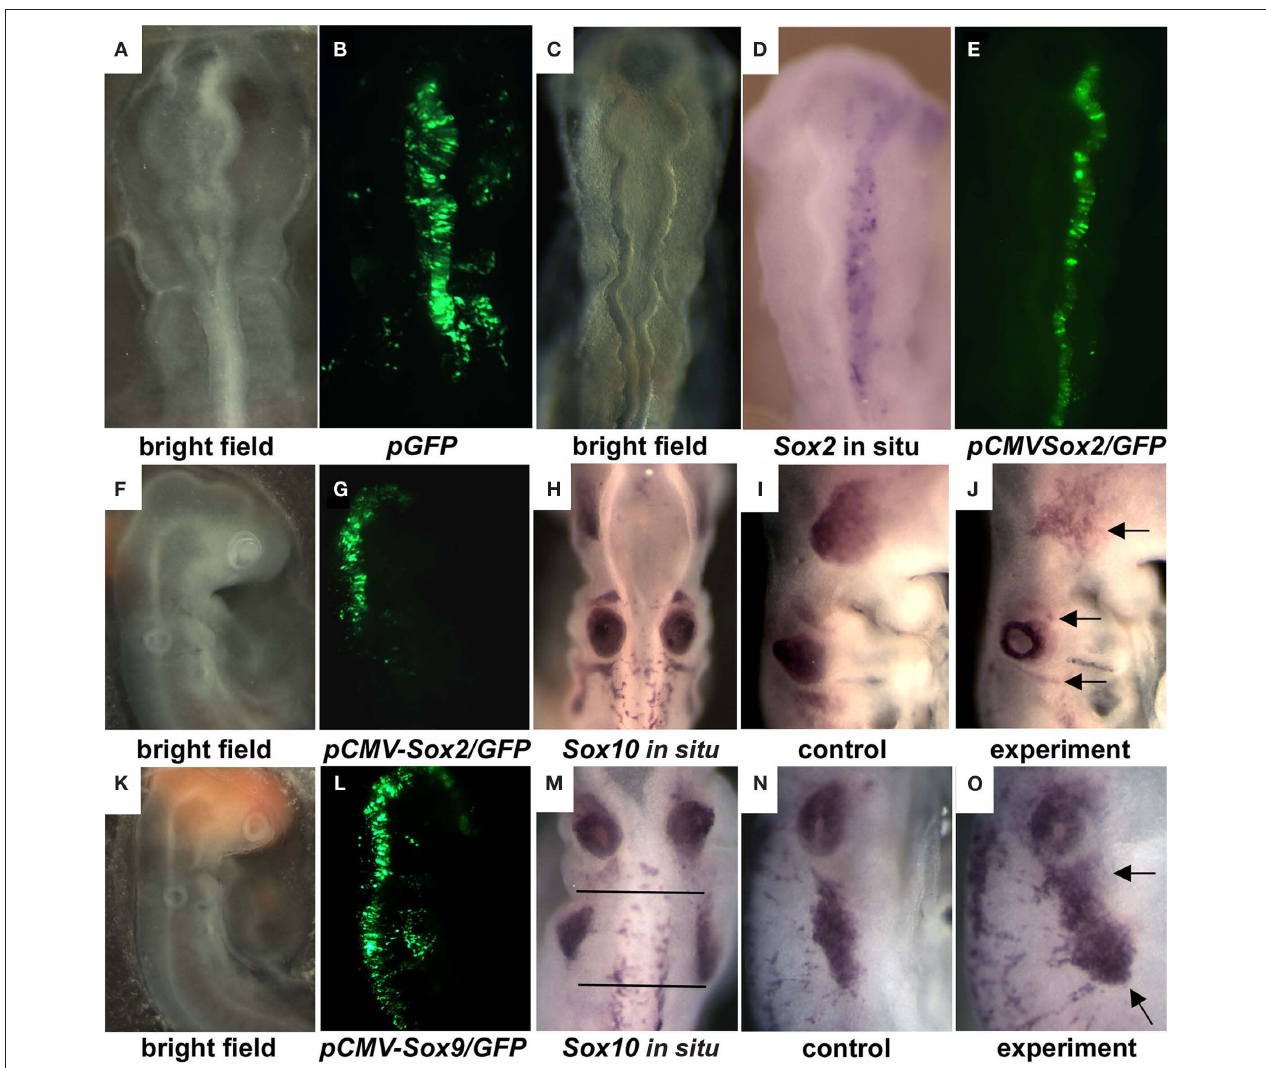
Figure A2 | Sox 2 restricts neuroepithelial differentiation into NCCs. Electroporation of a control pCMV–GFP plasmid into the cranial neural tube of a 1.5-day chick embryo (A) labels one side of the neural tube and its derived migrating NCCs (B) . In contrast, electroporation of pCMV– Sox 2/pCMV–GFP into the cranial neural tube of a 1.5 day chick embryo (C) leads to the overexpression of Sox 2 (D) and labeling of one side of the neural tube but these labeled cells are unable to give rise to migrating NCCs (e) . Overexpressing pCMV– Sox 2/pCMV–